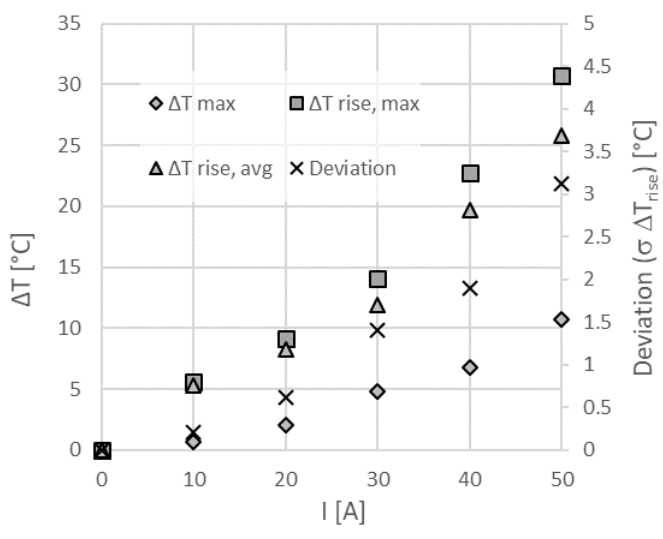
Figure 10. Relative temperatures and deviation in the natural convection.